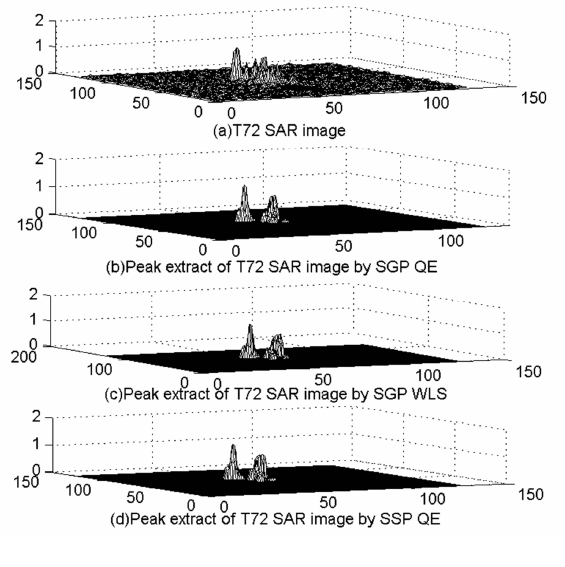
Figure 9 Recover Peak of 3D T72 by 3 Algorithms